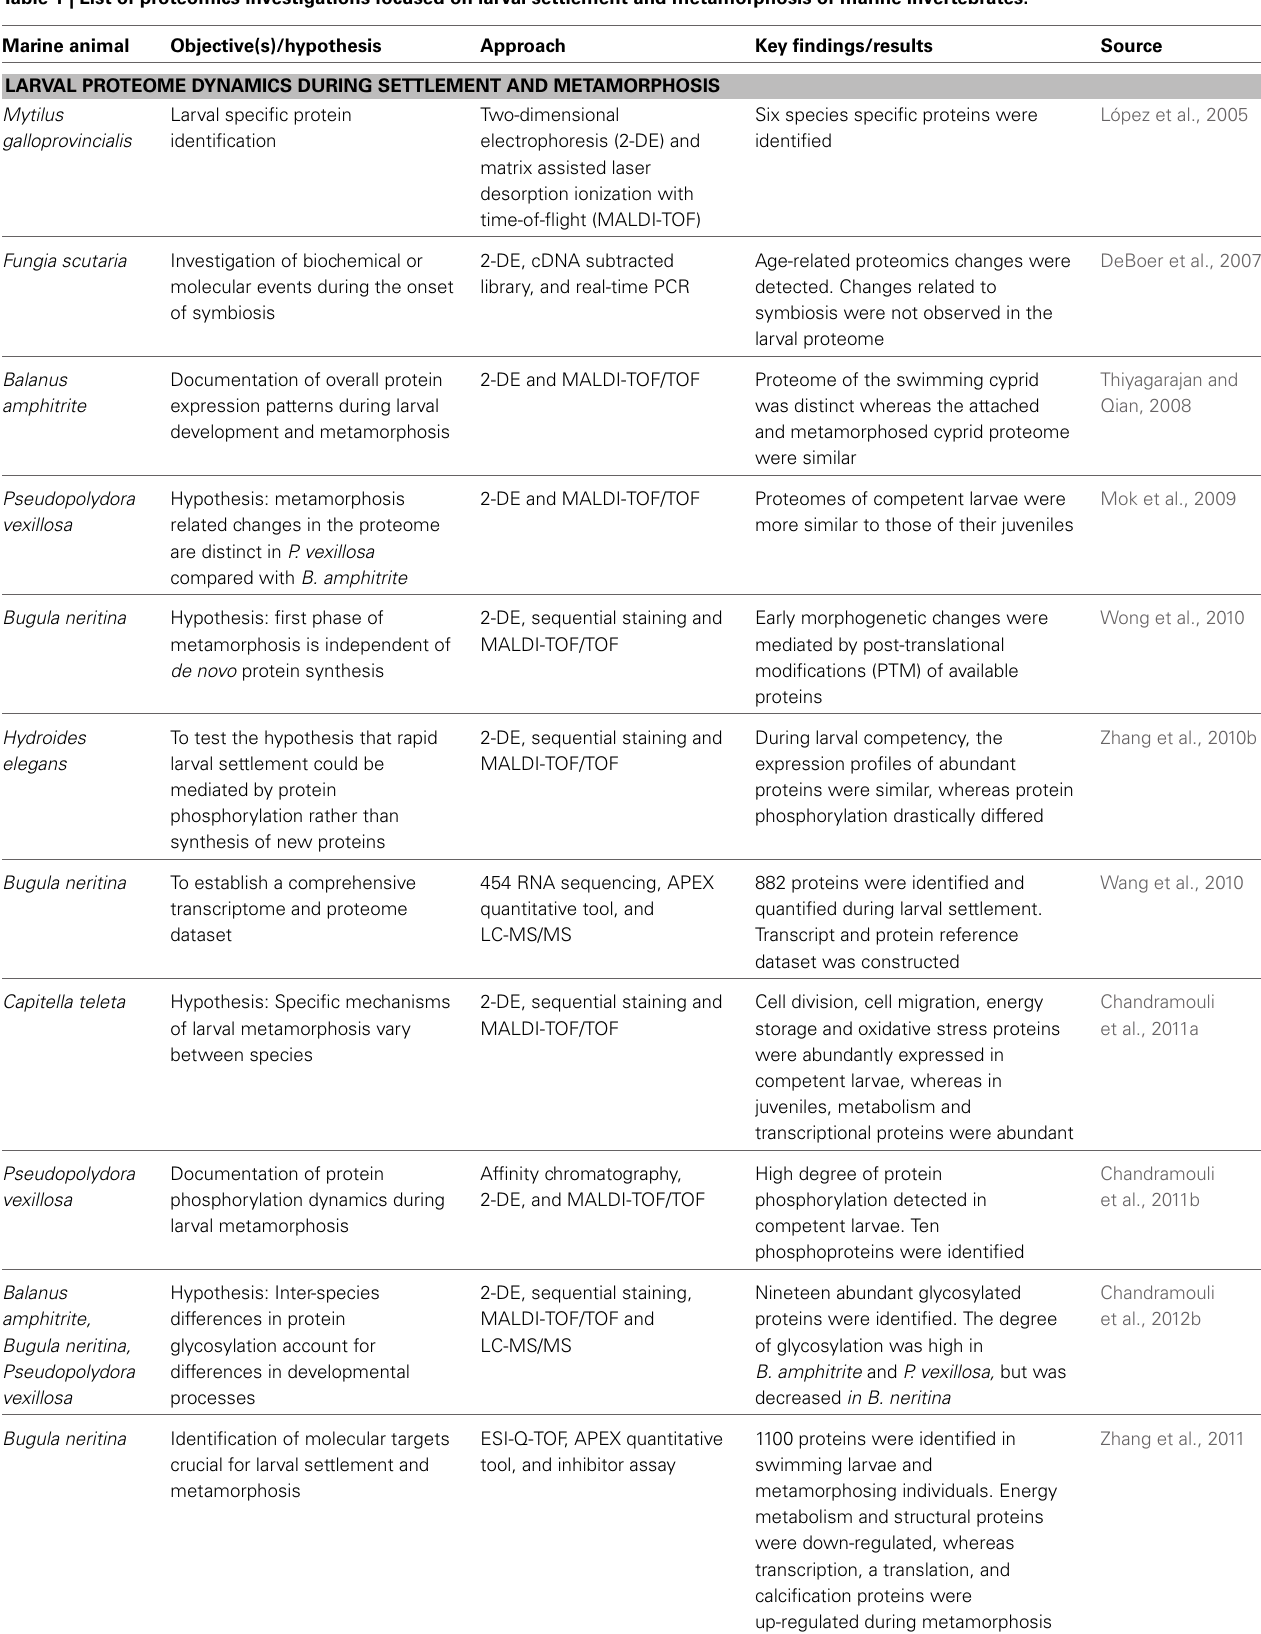
Table 1 | List of proteomics investigations focused on larval settlement and metamorphosis of marine